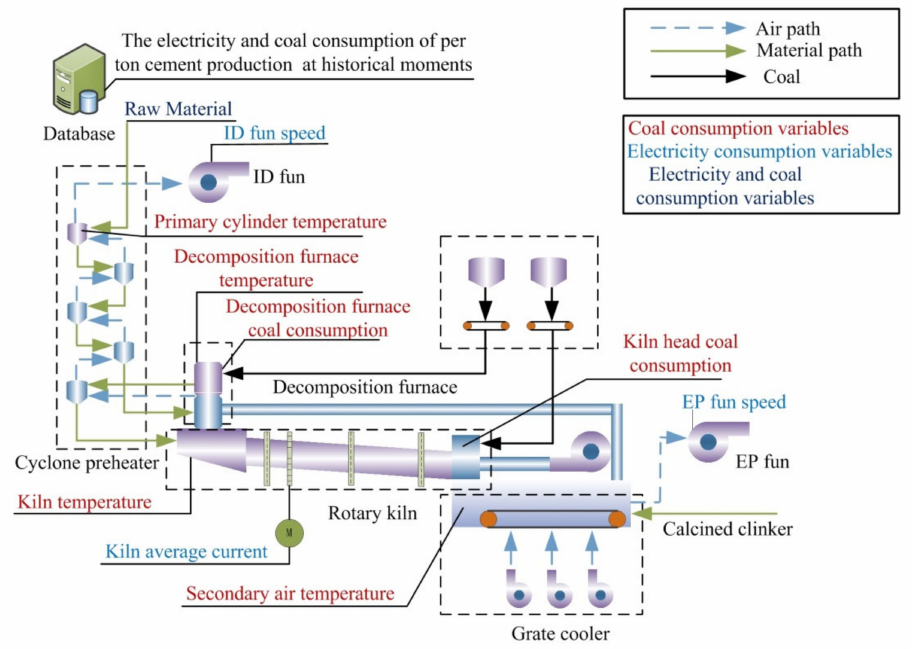
Figure 1. Calcination process of cement